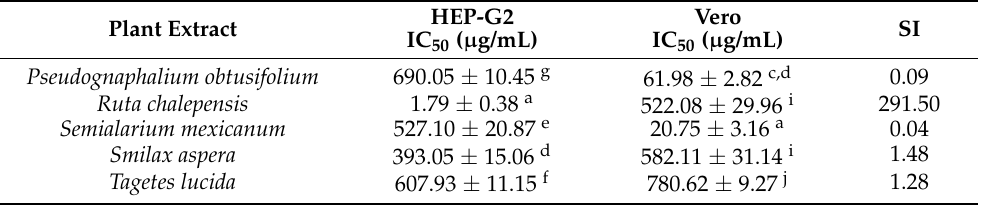
Table 2. Cont. Plant Extract Pseudognaphalium obtusifolium